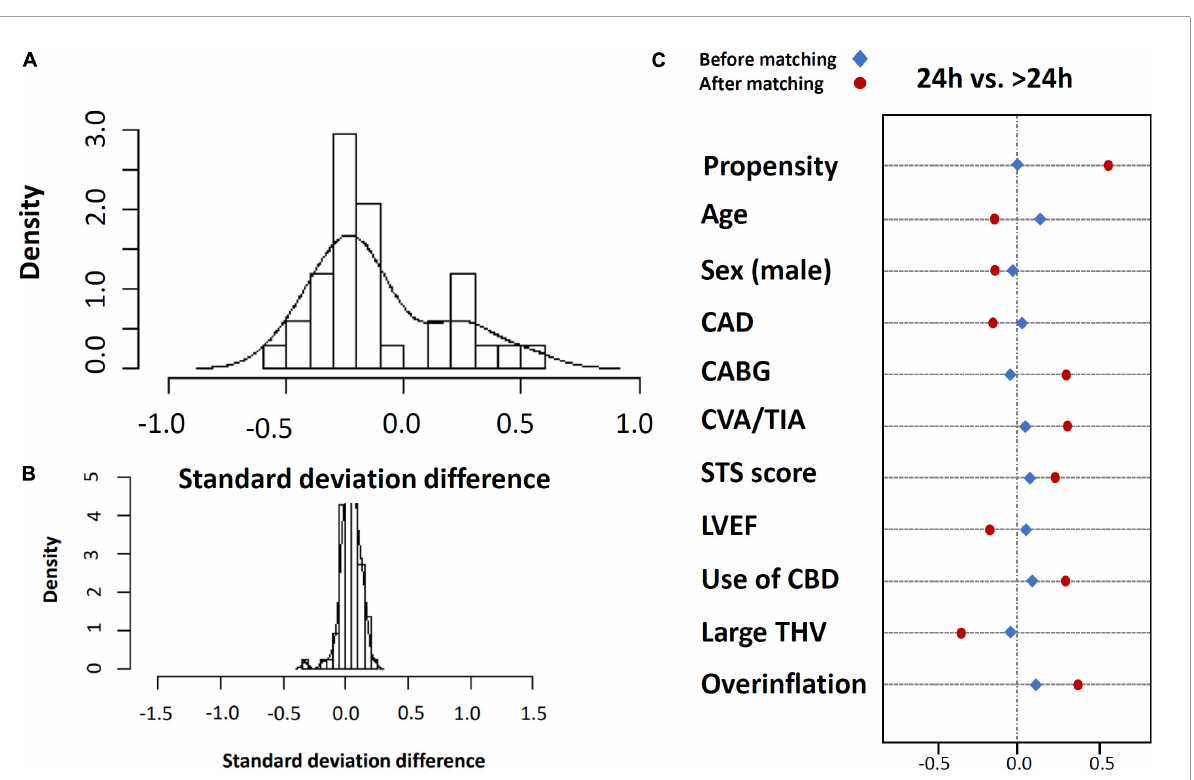
(optimism-corrected calibration-in-the-large of − 0.05; the slope of 0.97) ( Table 6